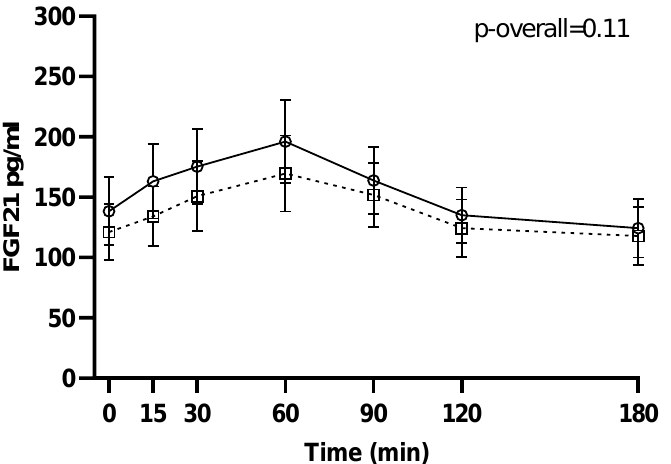
Figure 1. FGF21 during a three-hour mixed meal test approximately 1–2 weeks before (□, black dotted line) and 6 months after ( ○ , black filled line) surgery. Raw data shown as mean ± SEM. P-overall was obtained from a repeated measurements linear mixed model including a visit-time interaction and age and gender as fixed effects and participant as random effect. FGF21: fibroblast growth factor